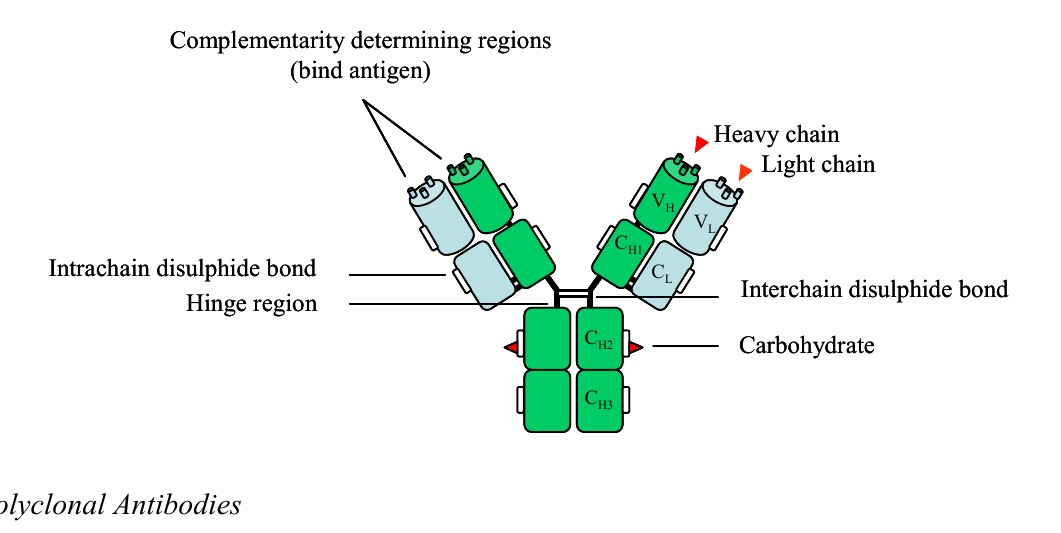
Figure 2. A schematic representation of an IgG antibody comprising of two heavy (green) and light (blue) chains. Carbohydrate elements are attached via the asparagine 297 amino acid residue. A more in-depth discussion of antibody glycosylation is provided in – variable heavy, V – variable light, C – constant heavy, C – reference [30]. Key: V H L H L constant